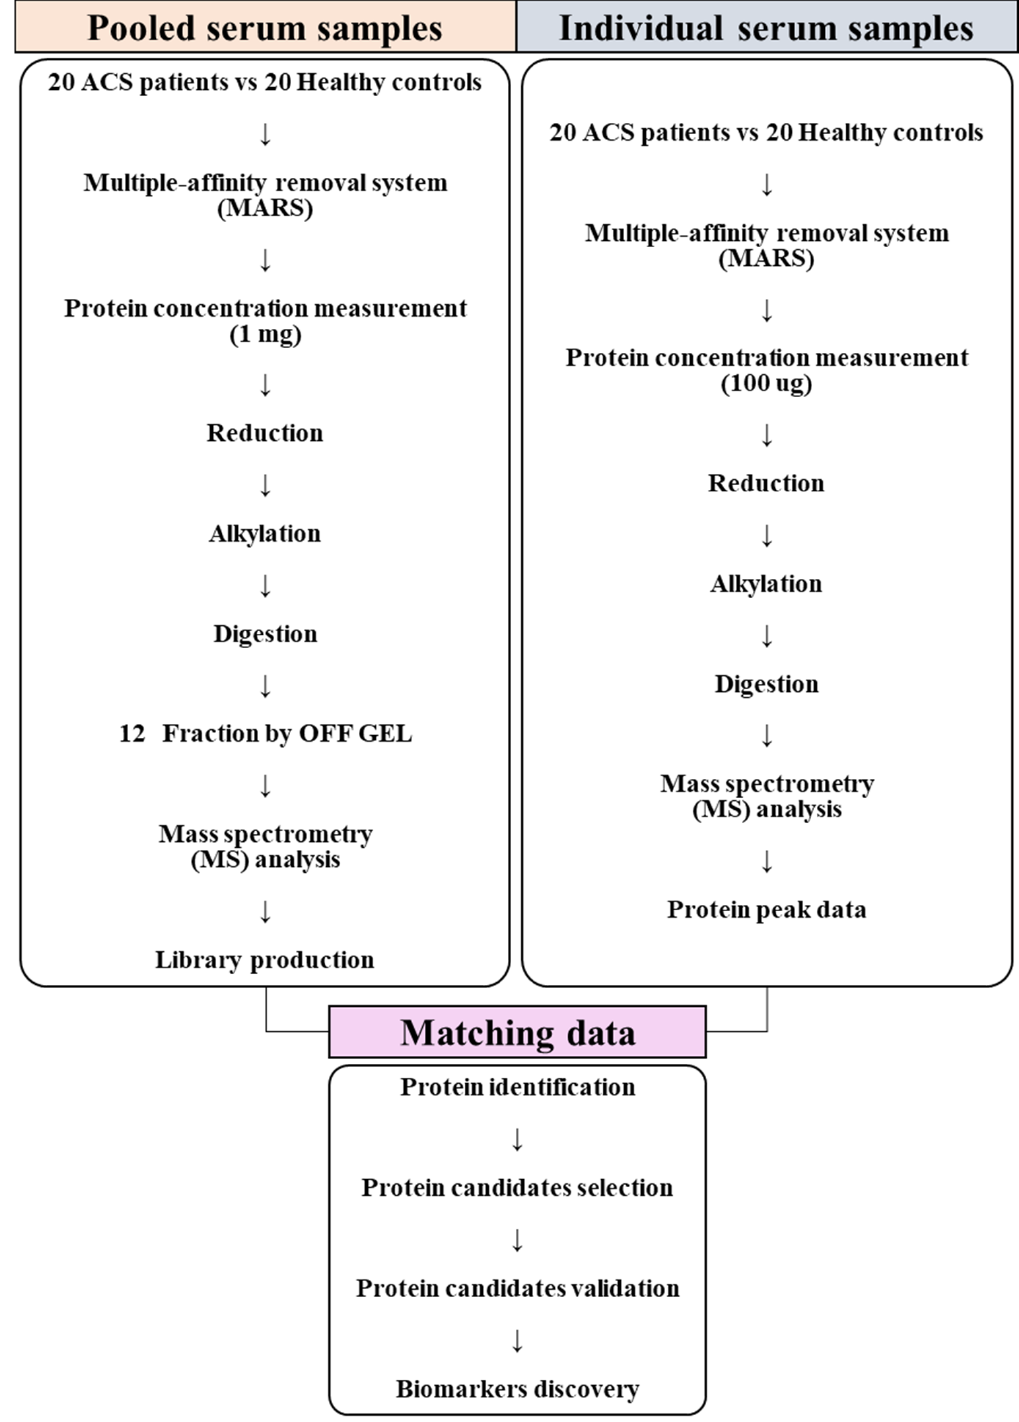
Figure 1. Flowchart of the experimental setup. Serum samples, consisting of individual and pooled serum samples, were collected from 20 patients with acute coronary syndrome (ACS) and 20 healthy controls and prepared for conducting mass spectrometry analysis. Pooled serum samples were analyzed using the information-dependent acquisition (IDA) mode to generate a library. Individual serum samples were analyzed using the sequential window acquisition of all theoretical fragment-ion spectra (SWATH) mode. Data produced using the SWATH mode were matched with the library for protein identification. After identifying the statistically significant proteins among all identified proteins, functional analysis was conducted to confirm the processes and functions associated with these proteins in ACS. Diagnostic biomarkers for ACS were selected through validation of the selected protein candidates.